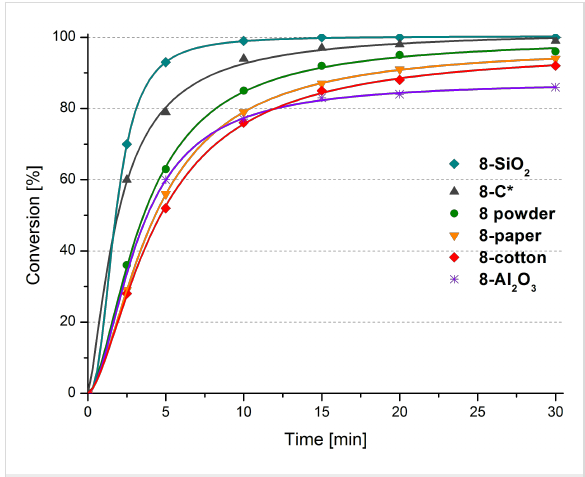
Figure 5: Influence of the support type on the metathesis outcome. Conditions: 1 mol % 8 , toluene 80 °C; [9] = 0.2 M.